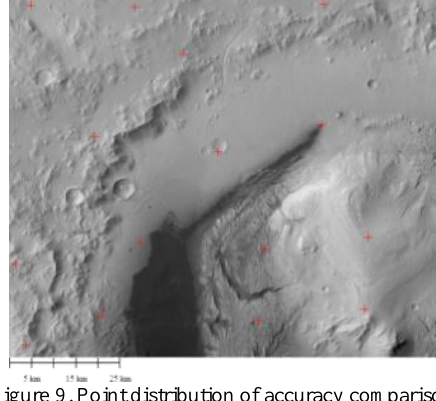
Figure 9. Point distribution of accuracy